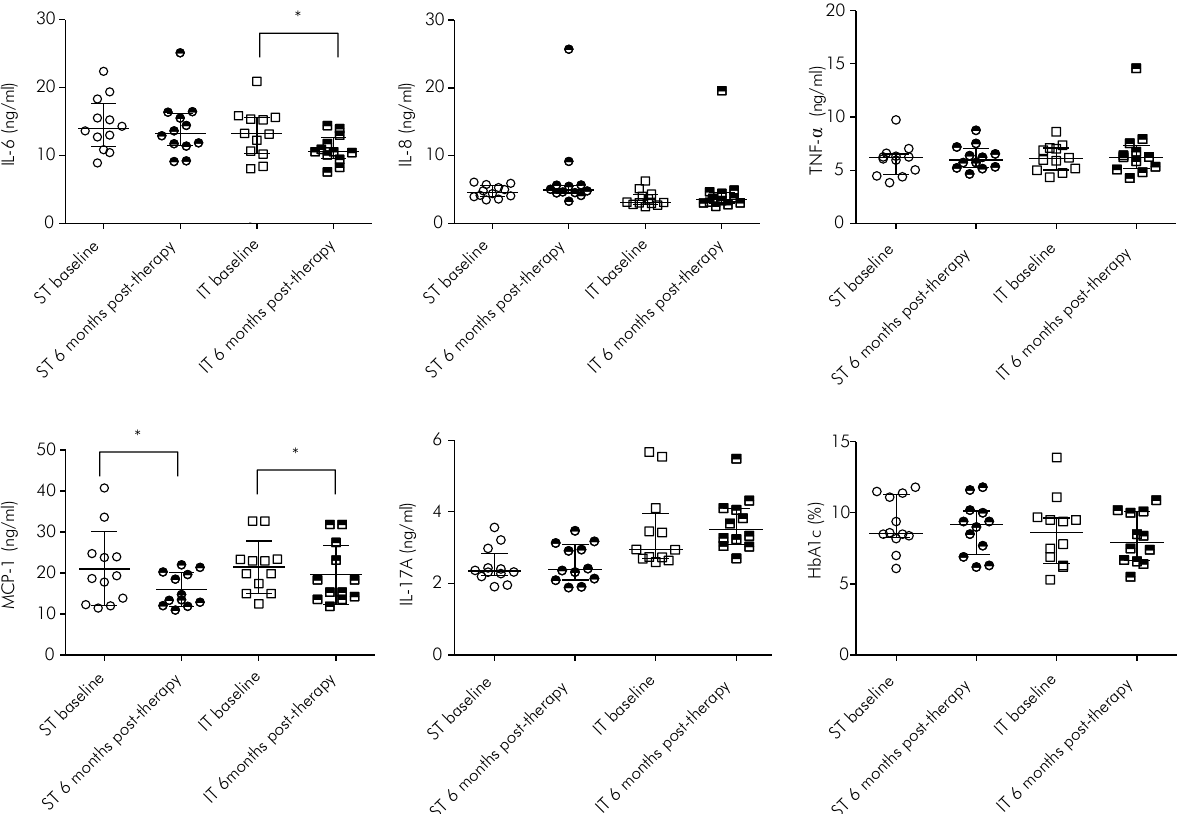
The diagram represents median values: inferior quartile (25%) and superior quartile (75%).*Statistical difference between the two groups (ST and IT) at baseline and 6 months post-therapy (p < 0.05; Wilcoxon signed rank test). Figure 1. Distribution according to the serum levels of IL-6, MCP-1, IL-8, IL-17, TNF-  , and HbA1c at baseline and 6 months post-therapy in the supragingival therapy (ST) and intensive periodontal therapy (IT)